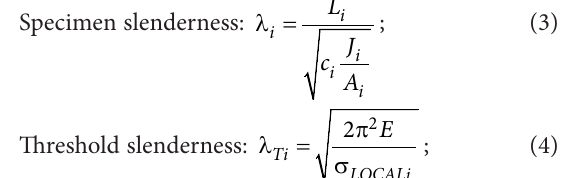
Table 3. Specification of stiffener geometry and mechanical characteristics Stiffener